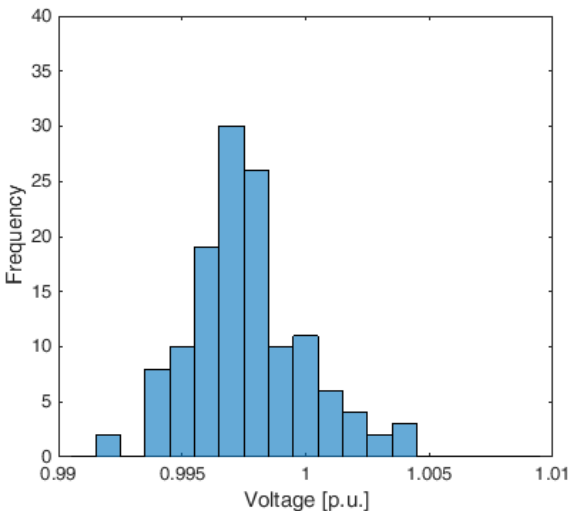
Figure 4. The histogram of the grid voltage amplitudes in Case 3 for the LinearDistFlow VOP